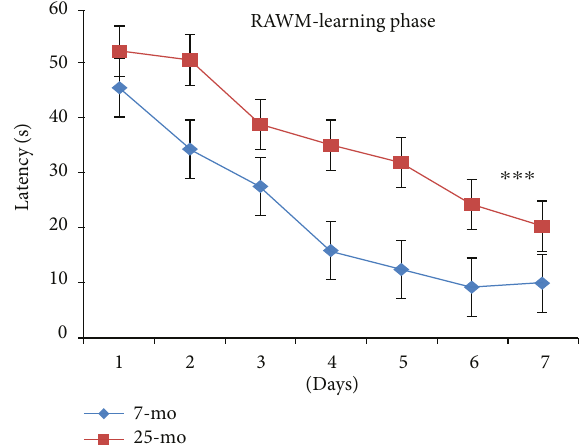
Figure 6: Latencies of 7- and 25-month-old C57BL/6 mice in learning phase of RAWM (s, mean ± SEM). ∗∗∗ P < 0 001 .